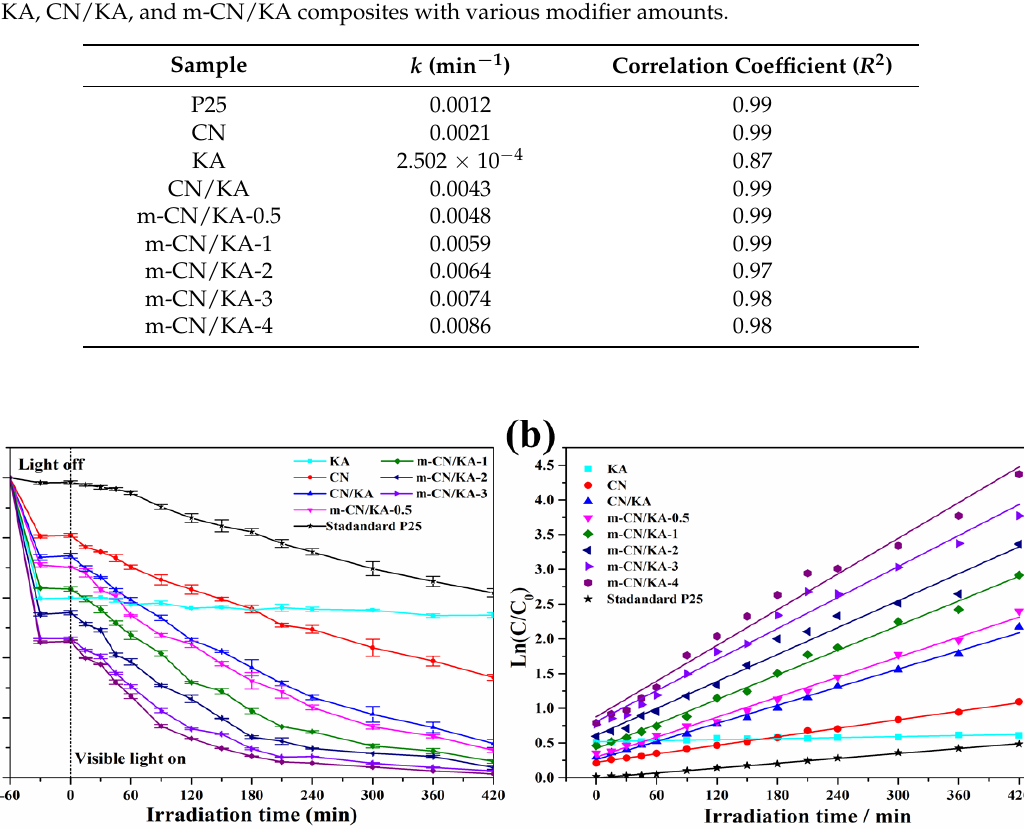
Table 2. Parameters of the pseudo-first order for RhB degradation under visible light over P25, CN, KA, CN/KA, and m-CN/KA composites with various modifier amounts.